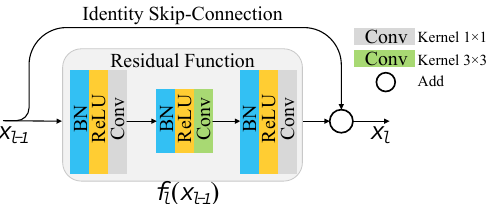
Figure 1. Architecture of a residual